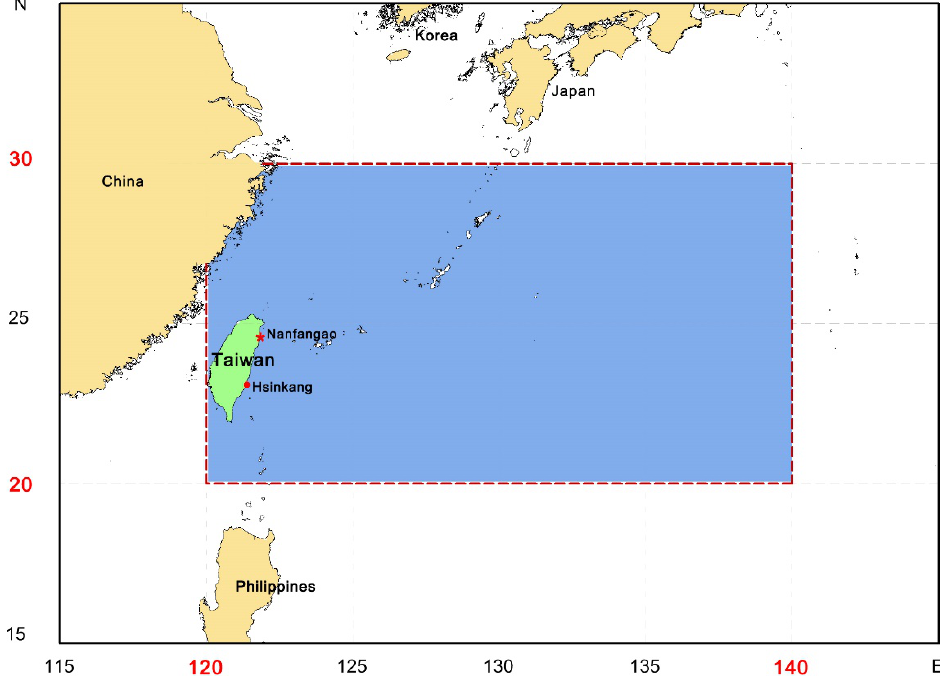
Figure 1. The study area (from 20° N to 30° N, 120° E to 140° E) in the present study. Red star is Nanfangao fishing port, red circle is Hsinkang fishing port. Table 1. The 20 pelagic fish species in the western North Pacific Ocean examined in this study.